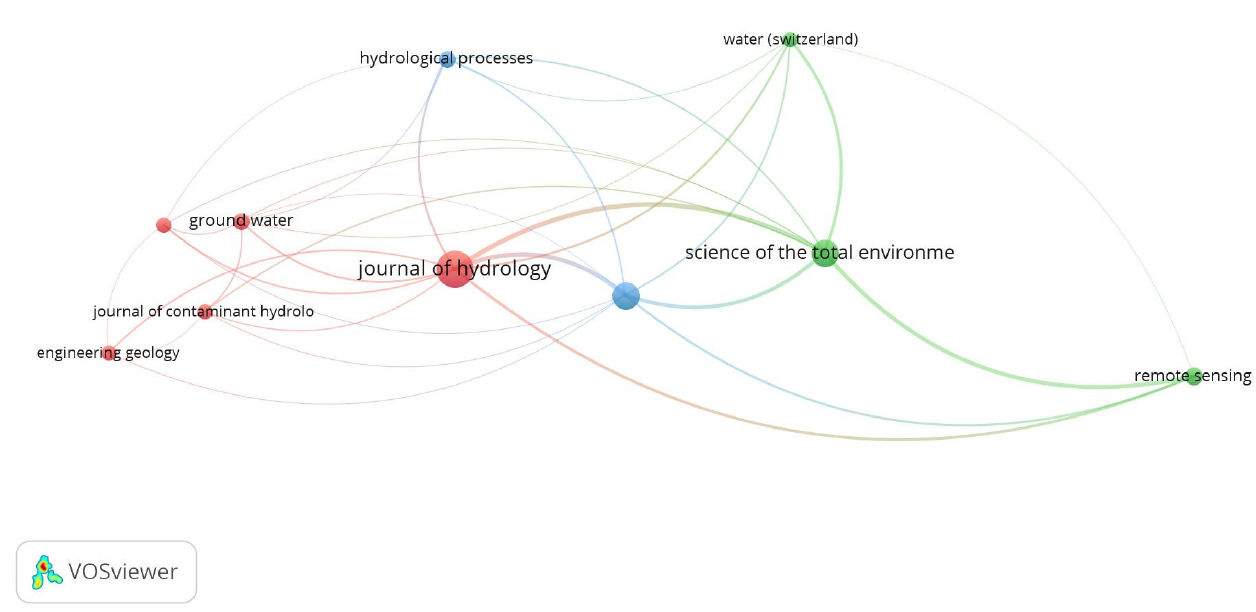
Figure 11. Co-citation of journals. The colors are clusters. Here we have three clusters.